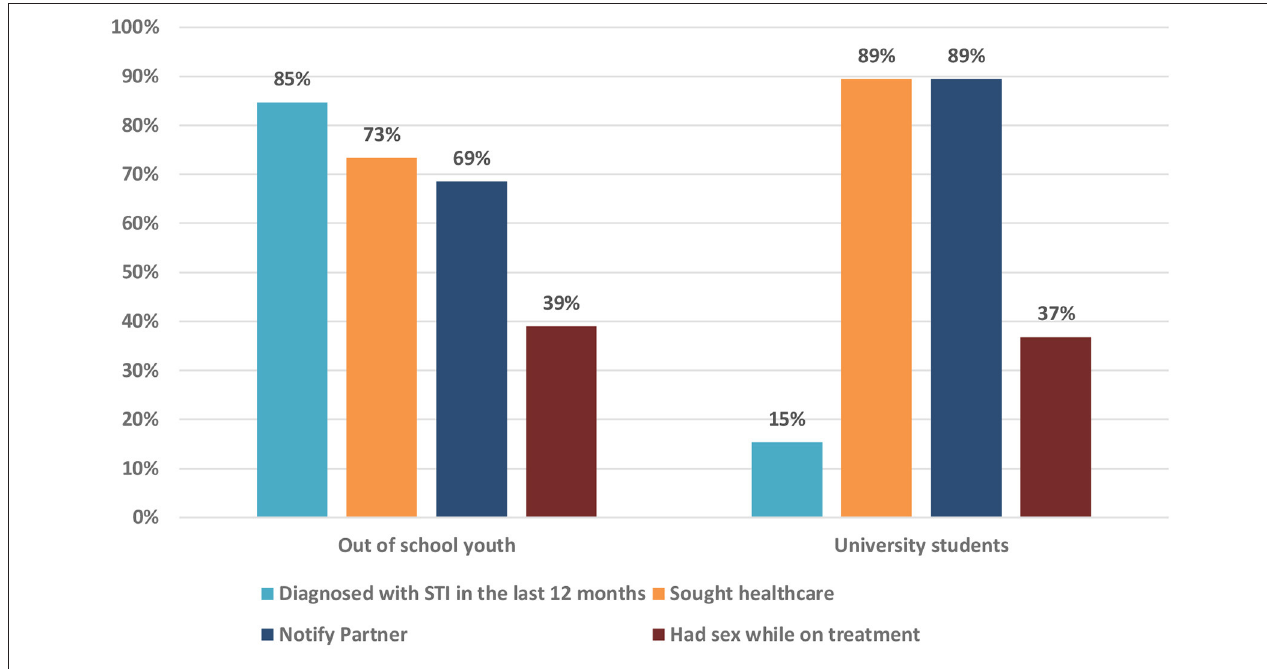
FIGURE 1 | Distribution of youth diagnosed with an STI in the past 12 months.